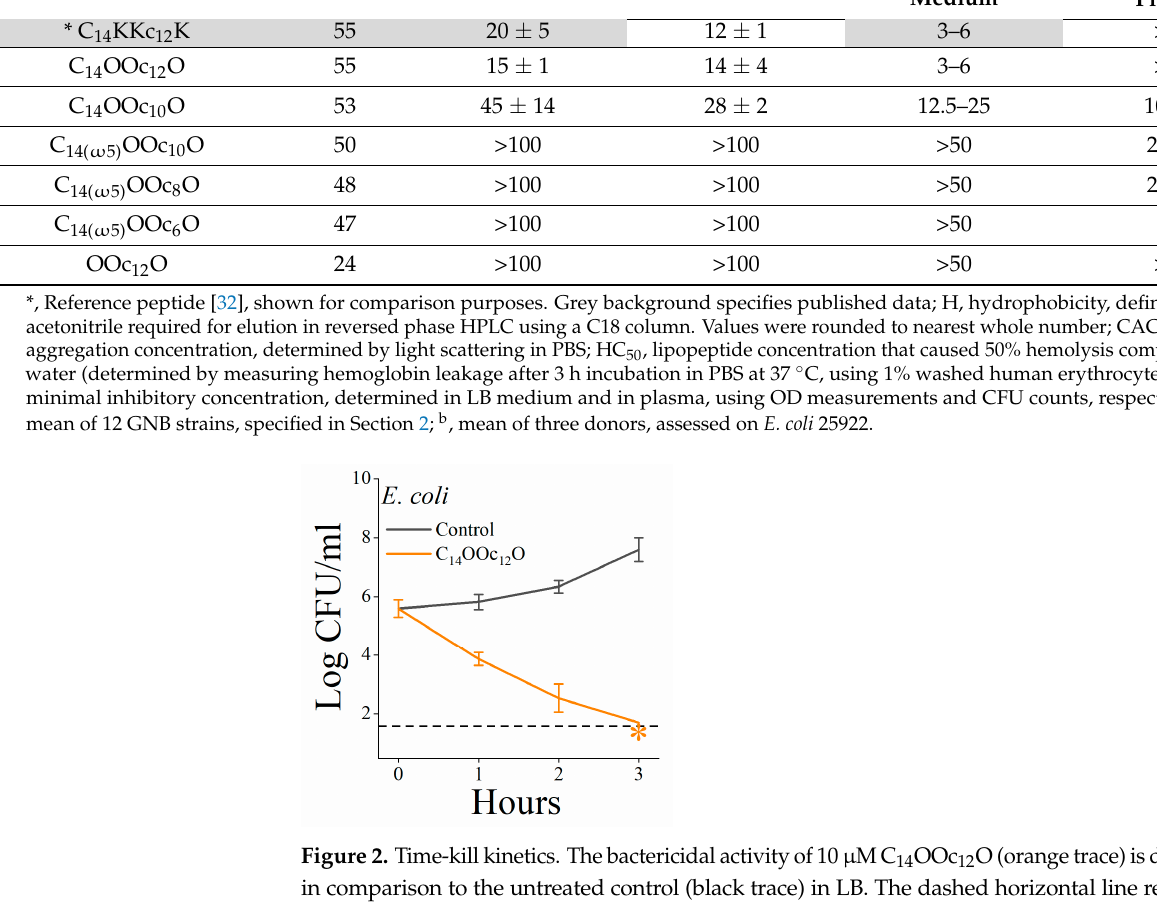
Figure 3. Animal plasma antibacterial activities against E. coli 25922. ( a ) Dose-dependent reduction of colony forming units (CFU) as determined 24 h after exposure to C 14( ω 5) OOc 10 O in human plasma (80% final plasma concentration in PBS). Val- ues represent the mean ± SD obtained from three individual plasma donors (mean inoculum was 1.6 ± 0.8 × 10 6 CFU/mL). ( b ) Time-kill kinetics determined upon E. coli exposure to 0, 2.5, 5, and 10 μ M C 14( ω 5) OOc 10 O (from top to bottom, respec- tively). Values represent the mean ± SD obtained from two individual plasma samples, each subjected to two independent assays. Panels ( c – f ), respectively, show the OAC’s concentration-dependent activities in plasma samples obtained from pig, cat, sheep, and dog. The three dashed horizontal lines respectively represent the average CFU count of the vehicle control (upper line), the inoculum (middle line), and the limit of detection (lower line), i.e., log 10 50 CFU/mL = 1.69. Green stars (*) denote lack of detectable CFU. Additional efforts to reduce hydrophobicity by substituting the A 2 position with less hydrophobic acyls led to no apparent improvement. Rather, C 14( ω 5) OOc 8 O and C 14( ω 5) OOc 6 O displayed a gradually weaker capacity to potentiate plasma (and antibiotics,